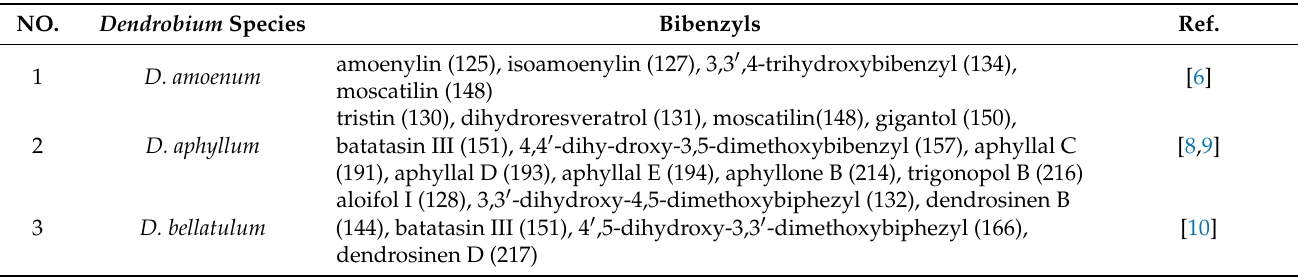
Table 2. Bibenzyls isolated in Dendrobium